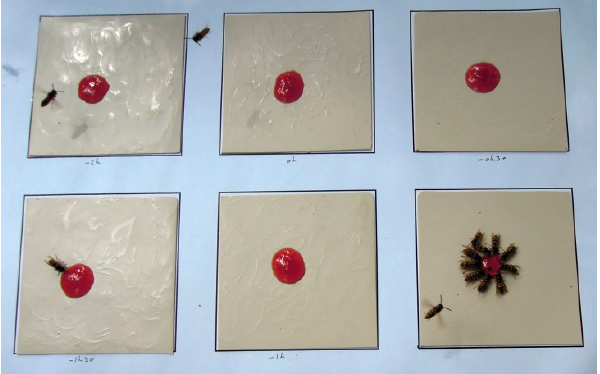
Figure 1. Picture of the running field test that involved Vespula vulgaris . Jam was used as an attractant. In the example shown here, the only surface not treated with the skin lotion was the one on the lower right corner. For further explanation, see text.